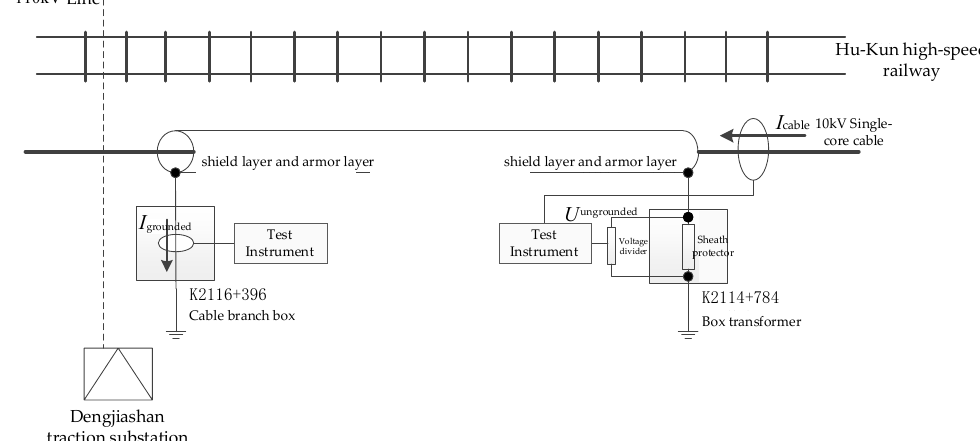
Figure 7. “Hukun 1” 10 kV feeder cable single-end grounding test structure.